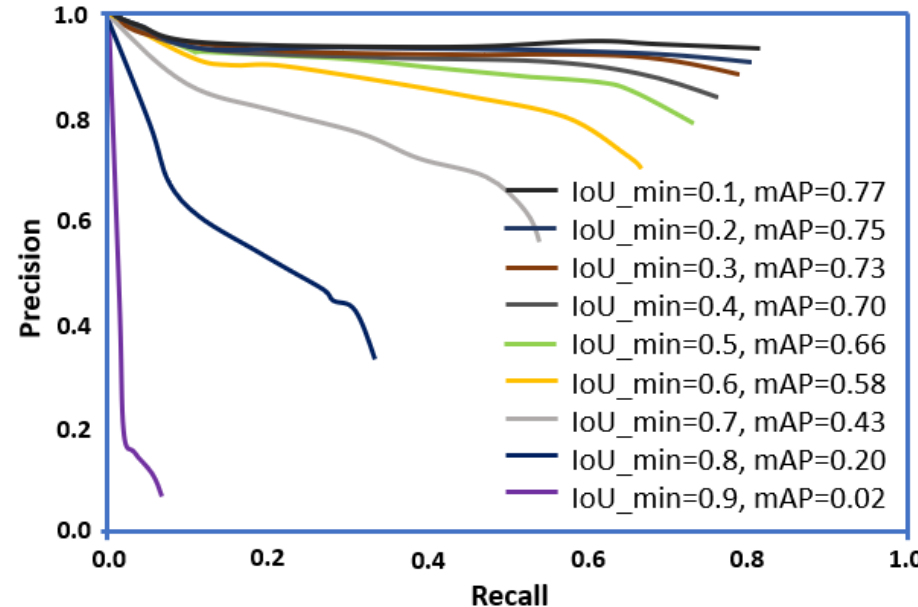
Figure 9. The precision-recall curves for the data set.